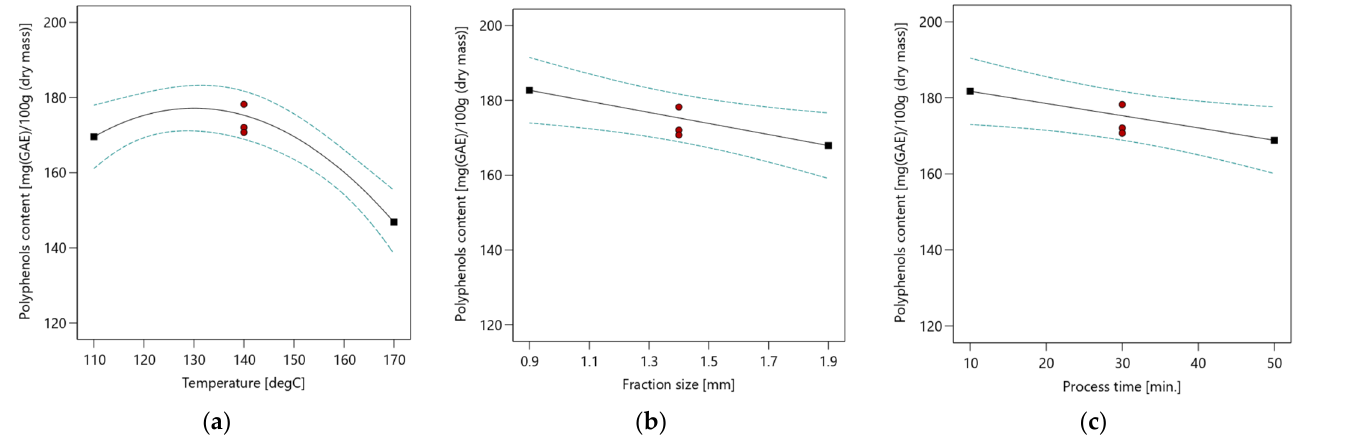
Figure 2. Polyphenols content for different subcritical extraction parameters ( a ) Polyphenols content as a function of extraction temperature; ( b ) Polyphenols content as a function of raw material fraction size; ( c ) Polyphenols content as a function of process time.